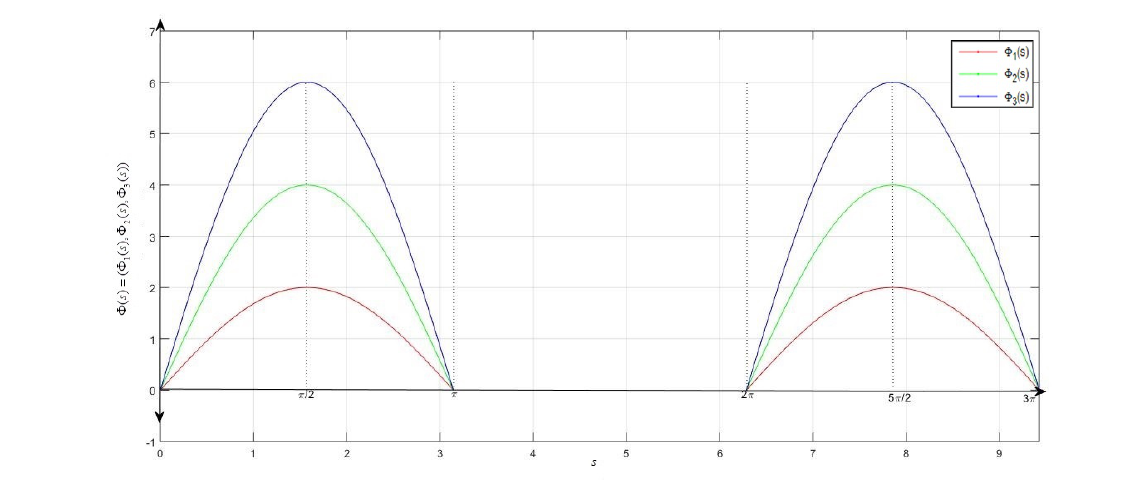
Figure 2. Graphical Representation of Φ ( s ) in Example